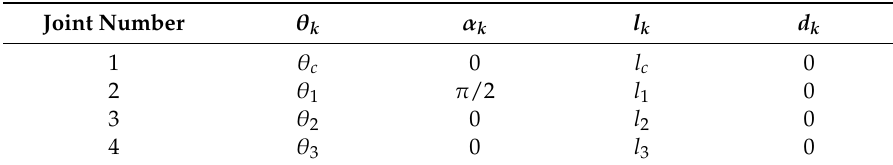
Table 2. MDH parameters of the right-middle leg.